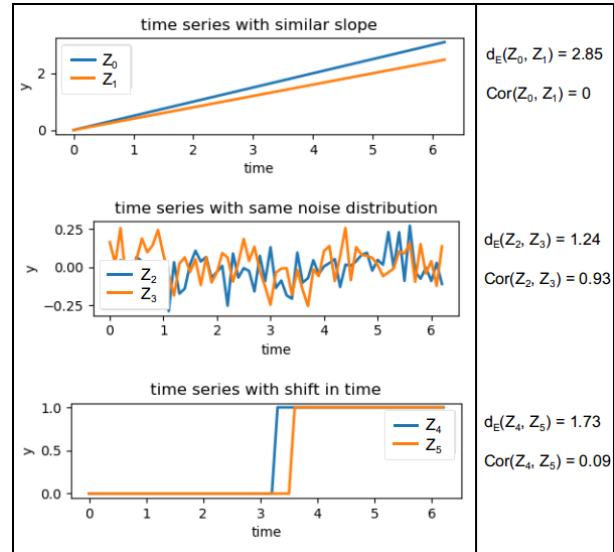
Figure 4. Example of three pairs of time series that are “similar” to each other in different ways. The Euclidean distance would sort the differences as follows: d E ( Z 2 ,Z 3 ) < d E ( Z 4 ,Z 5 ) < d E ( Z 0 ,Z 1 ), whereas according to the correlation distance the order would be Cor( Z 0 ,Z 1 ) < Cor( Z 2 ,Z 3 ) < Cor( Z 4 ,Z 5